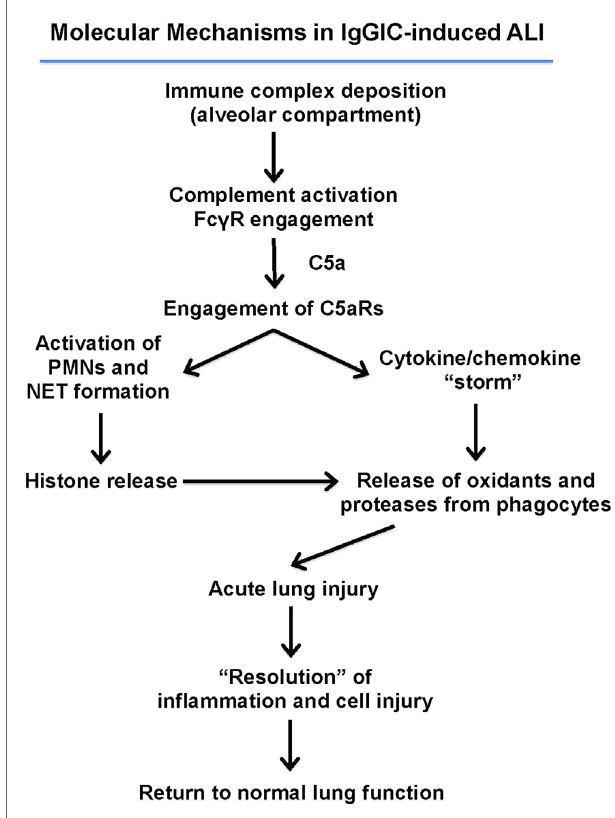
FiGURe 2 | Molecular mechanisms in igGiC-induced ALi . Airway position of IgG immune complexes leads to complement activation and generation of C5a. C5a interacts with its receptors C5aR1 and C5aR2 on neutrophils and on other cell types in lung (alveolar epithelial cells, endothelial cells, and macrophages) resulting in a surge of proinflammatory cytokines and chemokines. These interactions with neutrophils results in the formation of neutrophil extracellular traps (NETs), resulting in the release of extracellular histones, which are extremely cell-toxic, proinflammatory, and thrombogenic. These responses resolve and there is little evidence of residual functional or structural